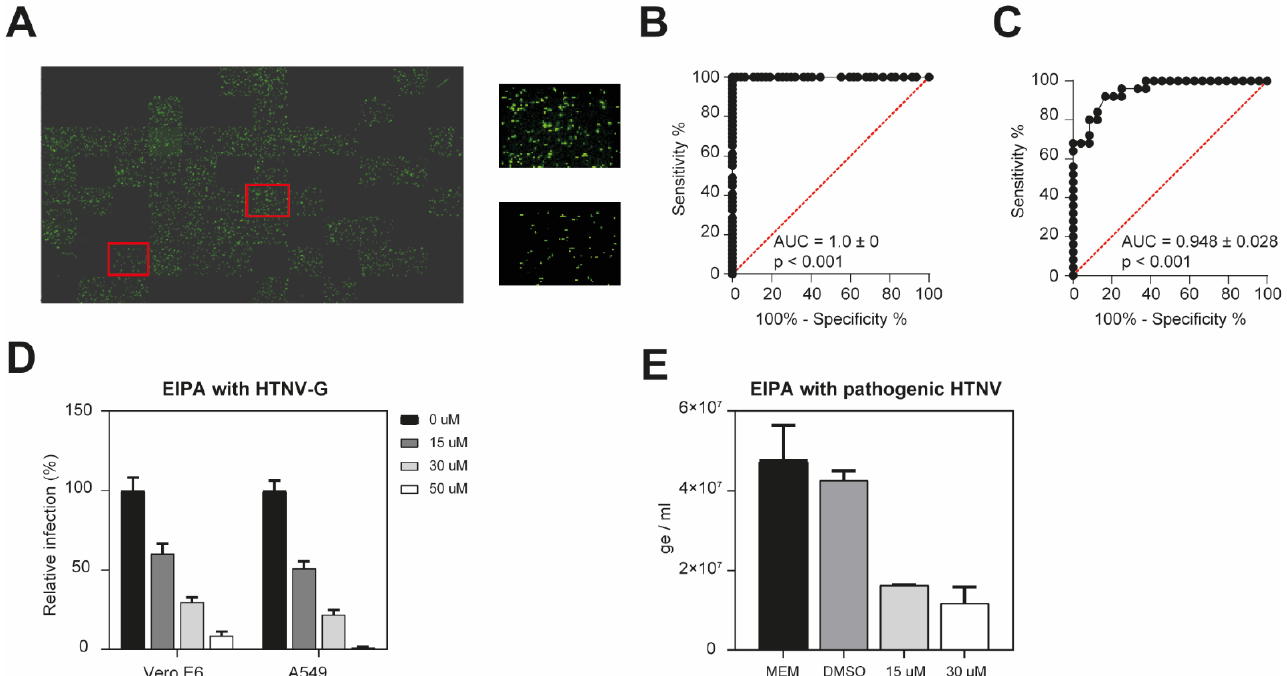
Figure 2. Performance of EGFP expression measurement as a method to differentiate non-treated from treated infected cells. ( A ) Representative image of a 96-well plate with two enlarged wells standing for treatment conditions. Three conditions were applied to confluent monolayers of A549 cells: no pre-treatment and no infection; no pre-treatment followed by infection with VSV* ∆ G-Luc(HTNV-G) (upper right panel); or pre-treatment with 50 µ M EIPA for 30 min (lower right panel), followed by infection with VSV* ∆ G-Luc(HTNV-G) in the presence of the inhibitor. After 16 h of incubation, cells were washed, fixed with 2% PFA, and the nuclei were stained (DAPI). The number of infected cells was then analyzed through GFP expression using fluorescent microscope. Representation of EGFP expression on the XLS microscope. ( B , C ) ROC curves obtained for non-infected vs. infected cells ( B ) and for non-treated vs. EIPA-treated cells ( C ). The AUC and significance level are shown in each case. ( D ) EIPA inhibits HTNV-G in Vero E6 and A549 cells. Monolayers of Vero E6 or A549 cells were pre-treated with indicated concentration of EIPA for 45 min at 37 °C, followed by VSV* Δ G-Luc(HTNV-G) infection at 200 IU/well for 90 min. Cells were then washed and complete medium with 20 mM ammonium chloride was added and incubated for 16 h. The infection levels were assessed by counting the EGFP-positive infected cells. Data are means + SD ( n = 3). ( E ) EIPA inhibits HTNV infection. Vero E6 cells were pre-incubated with EIPA at the indicated concentrations for 45 min at 37 °C, followed by HTNV infection for 1 h at 37 °C. Cells were subsequently washed once with medium and incubated with medium containing appropriate drug concentration for 48 h. Infection levels were assessed by RT-qPCR. Data are means + SD ( n = 3) of genome per mL.